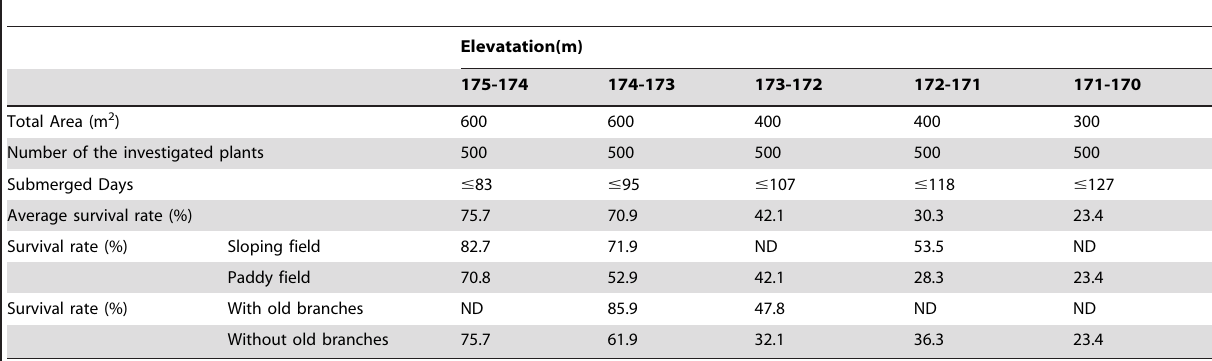
Table 4. Survival rate analyses of M. alba in 2012 planted in the Xiaohe village